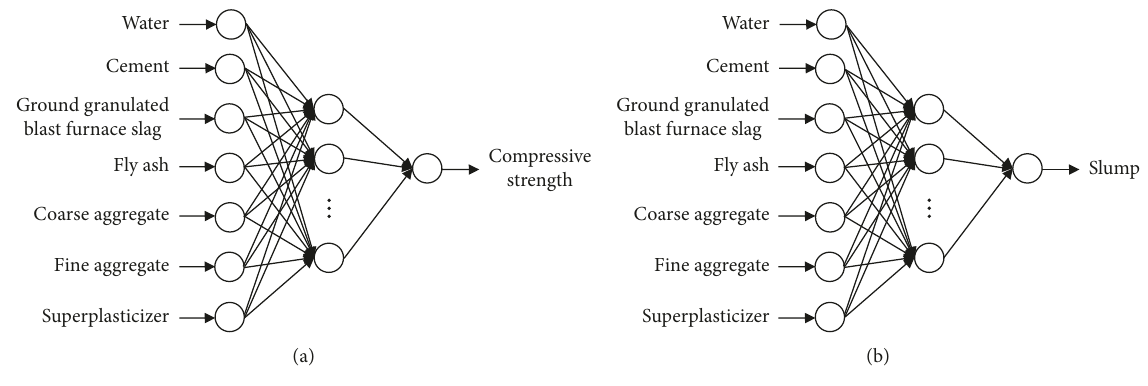
Figure 1: The architectures of (a) CSPNN and (b) SPNN.